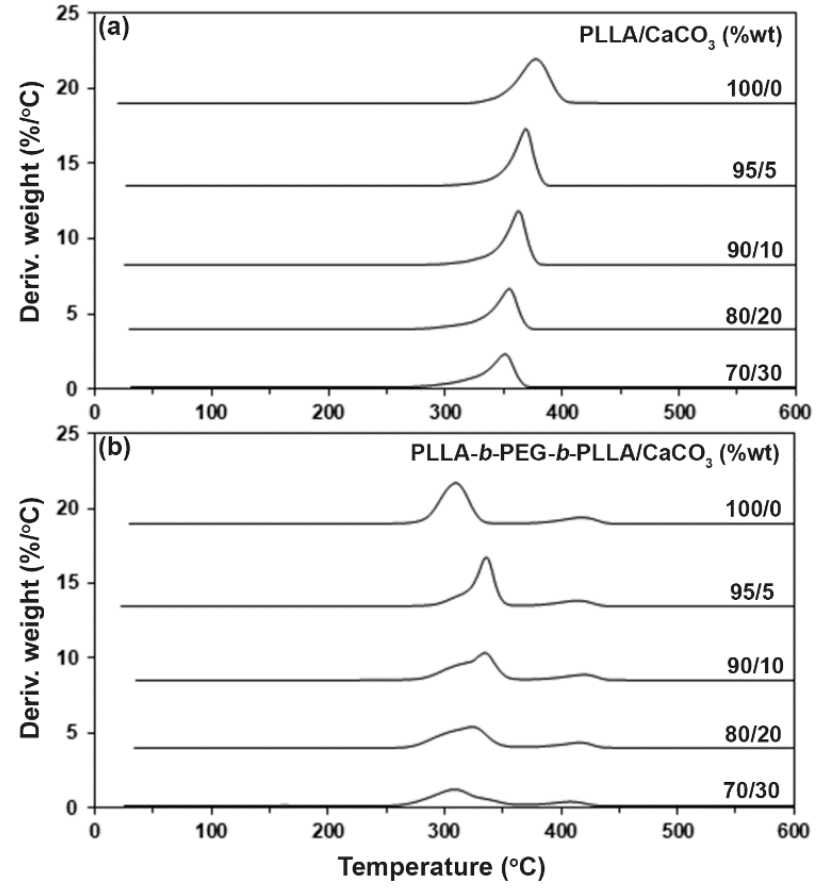
Figure 6. DTG thermograms of ( a ) PLLA/CaCO 3 and ( b ) PLLA- b -PEG- b -PLLA/CaCO 3 composites with various CaCO 3 ratios. Table 3. Thermal decomposition properties of the composites.